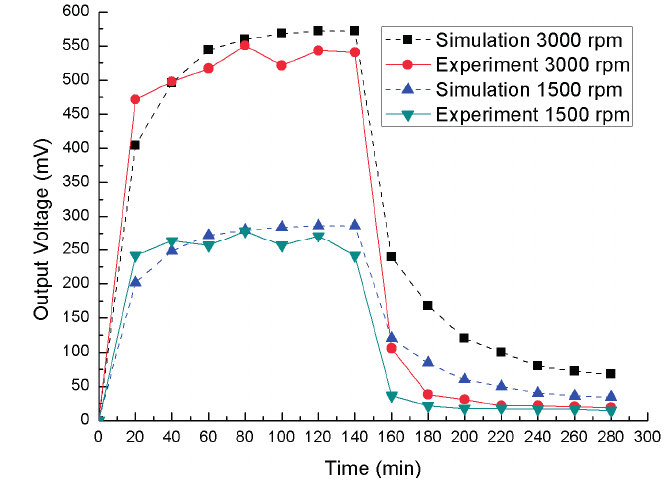
Figure 3. Output voltage of simulation and